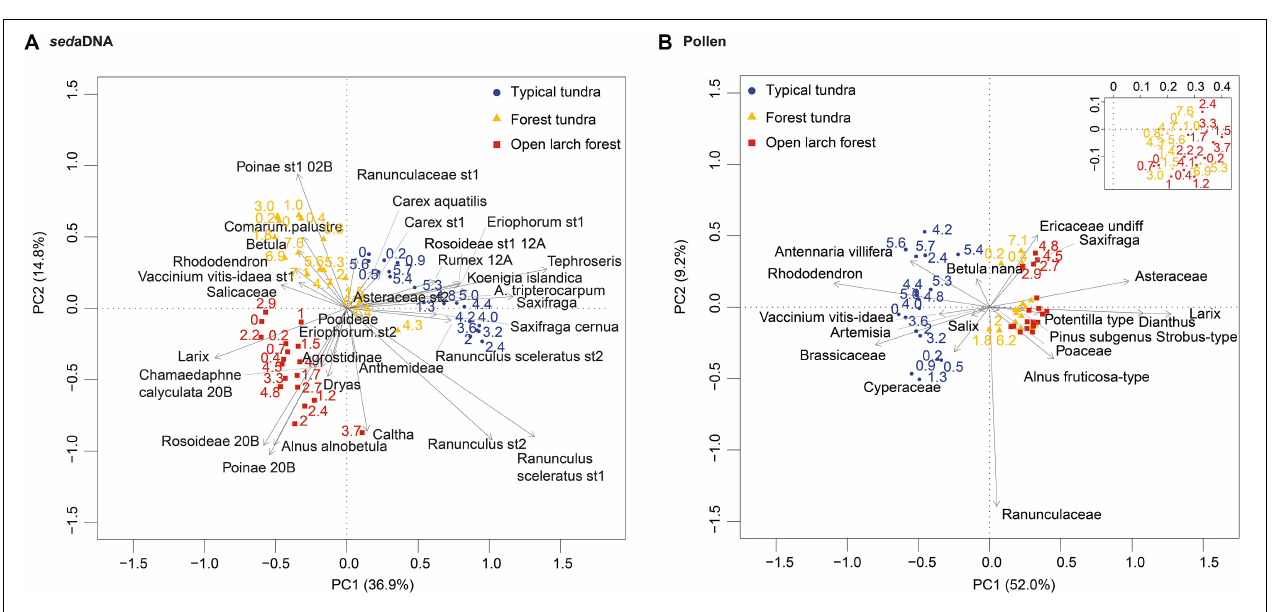
FIGURE 7 | Biplots of the two principal component analyses of the sed aDNA data (A) and pollen data (B) indicating that past changes in vegetation along latitudinal gradients can be distinguished by sed aDNA but not by pollen analysis. The percentages represent the total variance in corresponding